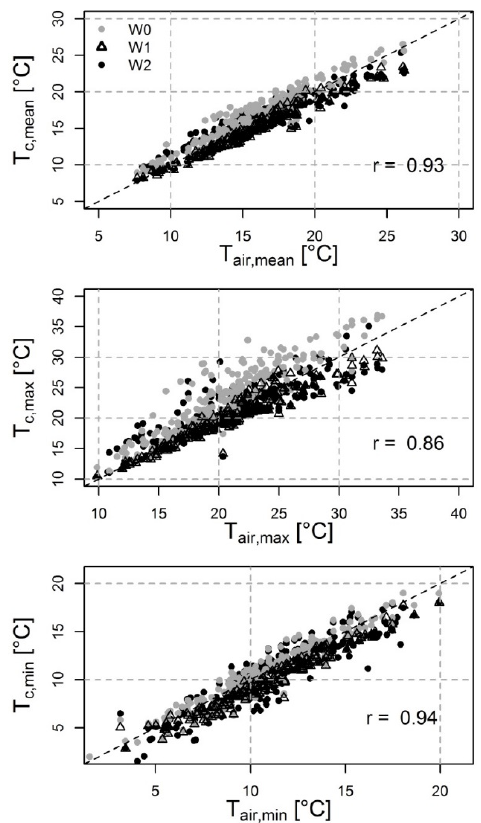
Figure 2. Scatter plot of mean, maximum and minimum canopy temperatures (T c ) and mean, maximum and minimum air temperatures (T air ) derived from the aggregation of hourly measurement data to daily values for three different irrigation treatments (W0 = no irrigation, W1 = medium deficit irrigation and W2 = full irrigation, r = Pearson’s correlation coefficient). The dashed black line indicates the line of identity.